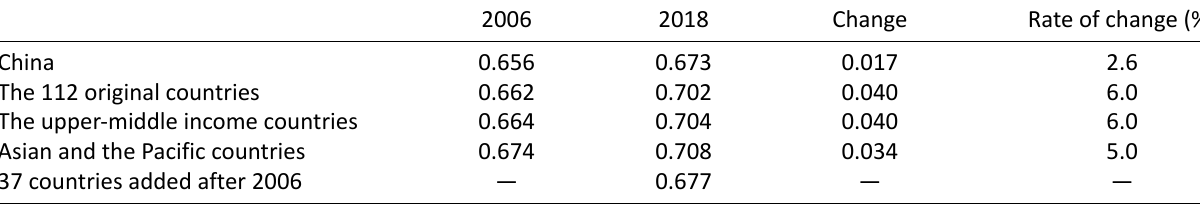
Source: WEF (2006,